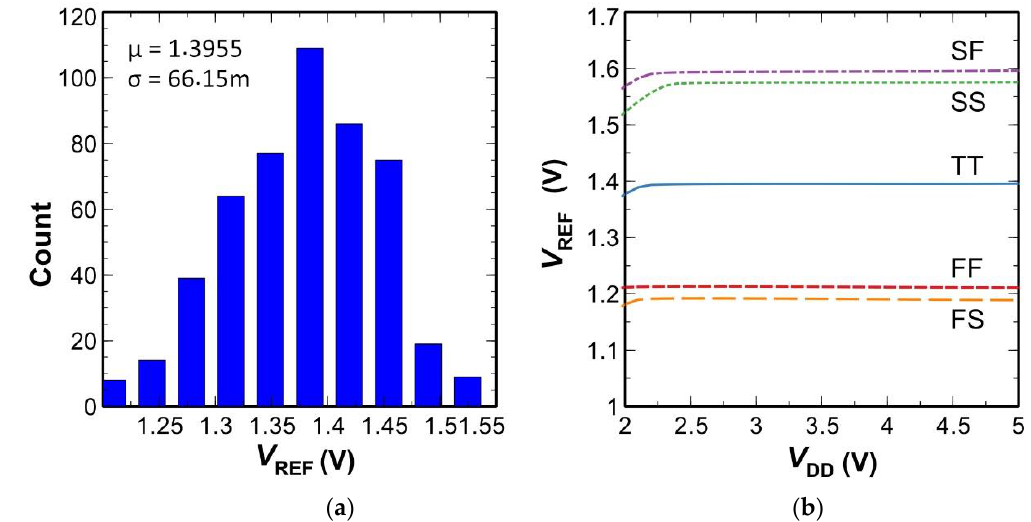
Figure 5. ( a) 500 Monte Carlo simulation results at 3.3 V supply, 27 °C; ( b ) line regulation results in different corners. Table 2. Electrical performance summary and comparison of reference circuit with previous